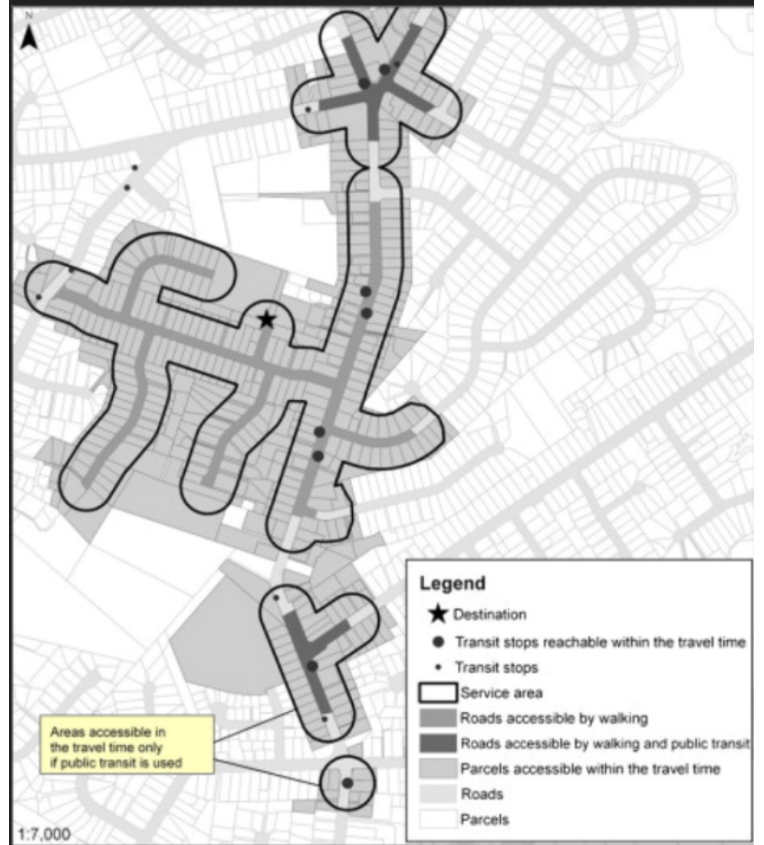
Figure 3. A service area mapped based on the road network and cadastral parcels